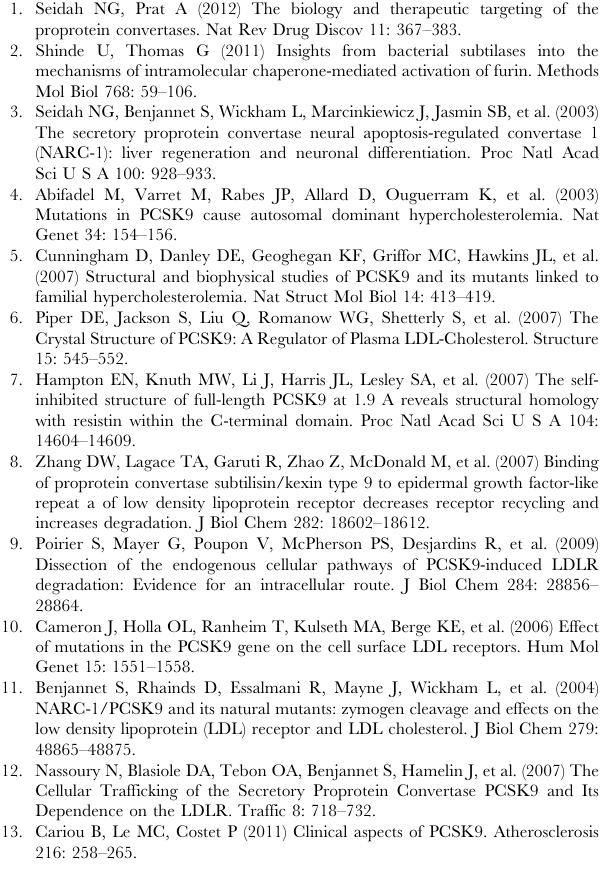
Figure S4 Loss of Fcpro binding capacity to a N- terminally V5-tagged PCSK9 prosegment. Concentrated conditioned media from HEK293 cells containing 2 m g of Fc or Fcpro or Fcpro QH proteins were resolved by 12% SDS-PAGE. Proteins were transferred onto a PVDF membrane and were incubated 4 h with conditioned media produced in HepG2/ shPCSK9 cells (expressing in trans a N-terminus V5-tagged PCSK9 prosegment and a no-tagged PCSK9 D prosegment) containing 5 m g/mL of N-terminally V5-pro-PCSK9. Binding of N-tagged PCSK9 to proteins bound on the PVDF membrane was detected by using our polyclonal homemade anti-human PCSK9 antibody. These data are representative of at least three independent experiments. B) pIR: control empty pIRES